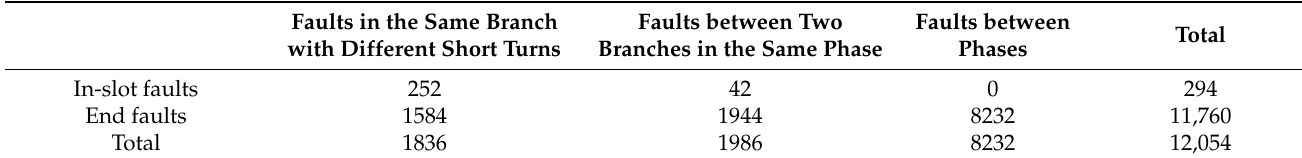
Table 5. The number of possible internal short-circuit faults in rotor windings.